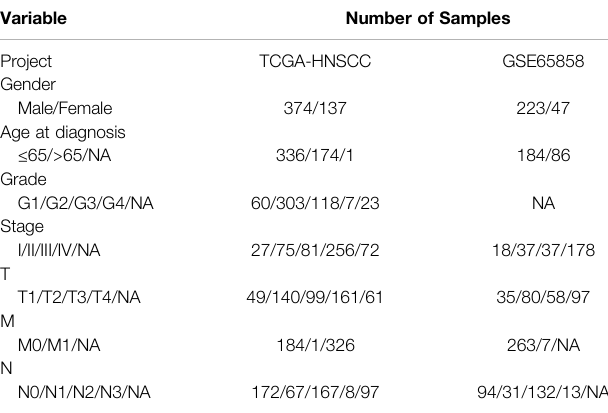
TABLE 1 | Characteristics of HNSCC patients in TCGA and